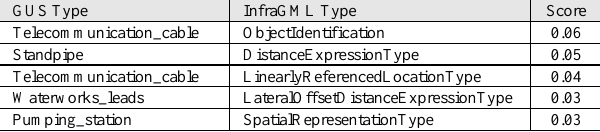
Table 6. GroupBy Type matching between GUS-InfraGML GUS Type